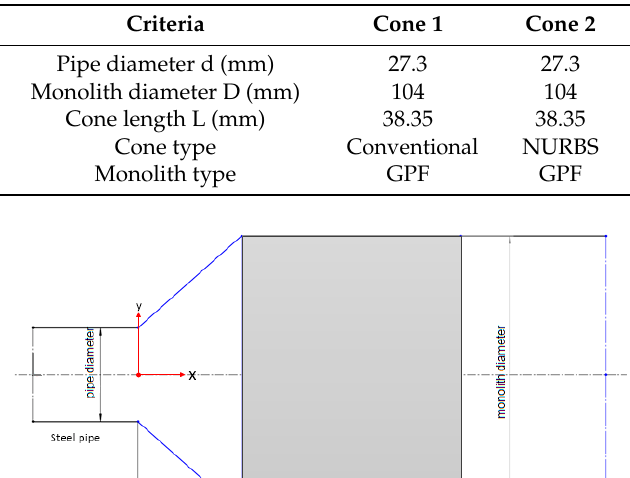
Table 2. Physical properties of the cones.